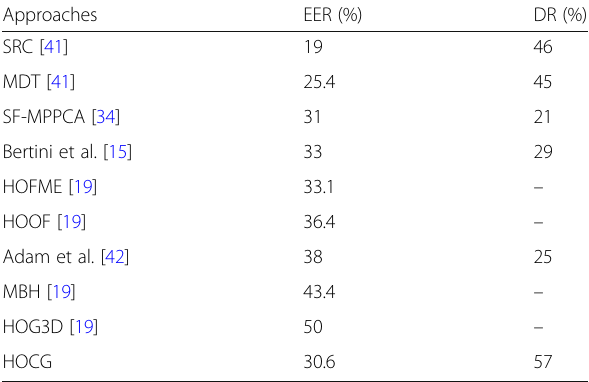
Table 1 Summary of the quantitative performance and comparison with state-of-the-art descriptors in the Ped1 dataset Approaches